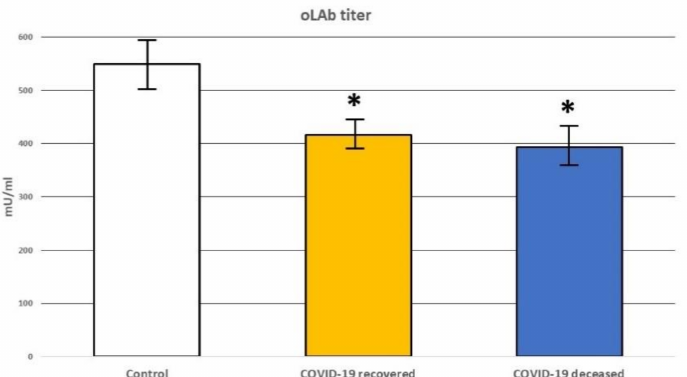
Figure 4. Changes in the level of antibodies directed against oxidative modifications of Low-Density Lipoprotein (oLAb) in the plasma of healthy subjects [Control] and recovered COVID-19 patients [COVID-19 recovered] and deceased COVID patients [COVID-19 deceased] . * means significant difference ( p < 0.05) to the healthy